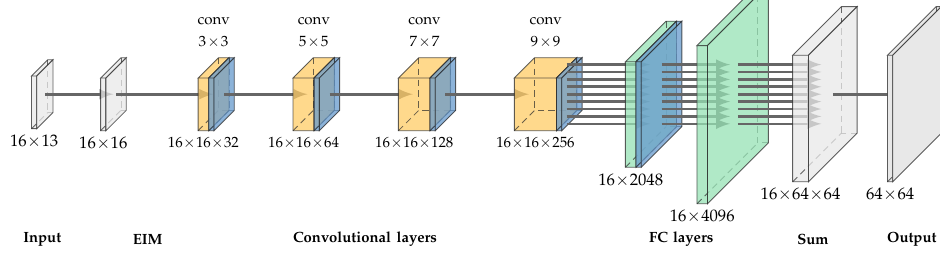
Figure 3. Illustration of the RF-REIM-NET structure. At the beginning, the 16 × 13 = 208 voltages are transformed into an EIM. From these, features are extracted with the help of convolutional layers. At the end, these features are processed by fully connected layers, which reconstruct the image for each injection